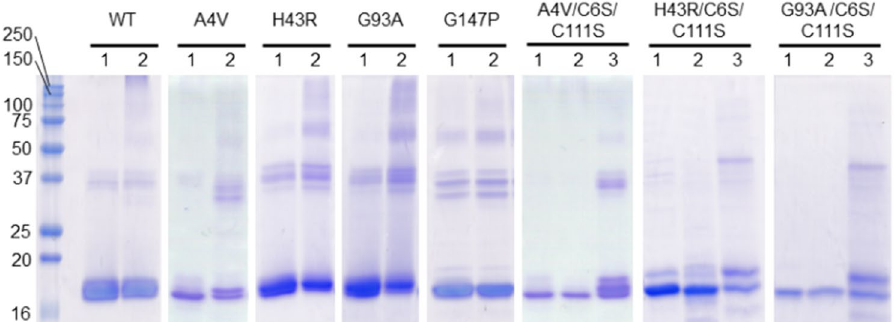
Figure 4. Non-reducing SDS-PAGE of apo-WT, apo-A4V, apo-H43R, apo-G93A, apo-G147P, apo-A4V/C6S/ C111S, apo-H43R/C6S/C111S, and apo-G93A/C6S/C111S in 50 mM phosphate buffer at pH 7.5. Lanes: 1, before incubation; 2, after incubation; 3, after incubation with 10 mM DTT. Details of the incubation conditions are given in Materials and methods and in the